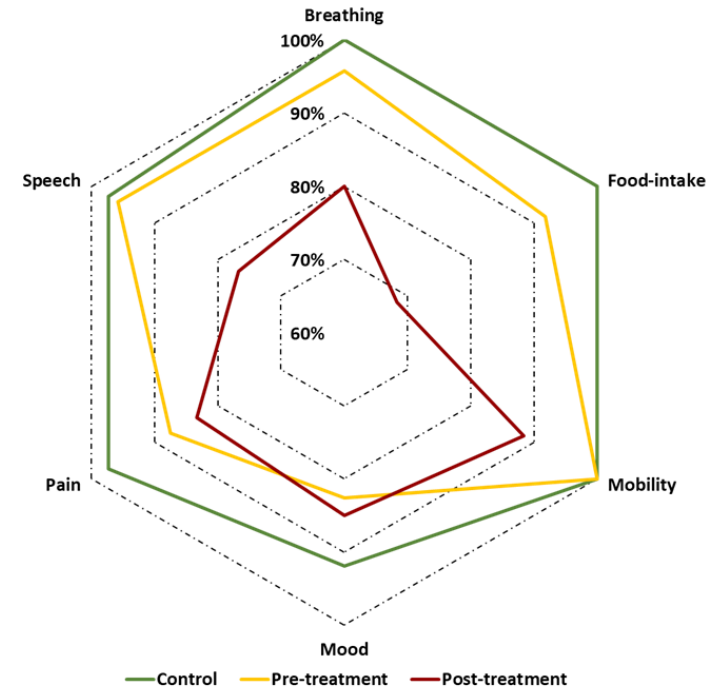
Figure 1. Star plot showing the percentages of normal and near-normal scores (functional integrity; scores 3 and 4) for controls (green line), HNC patients before therapy (yellow line), and HNC patients after therapy (red line). The star axes represent the percentages of study participants with functional integrity for the functional domains breathing, food intake, neck and shoulder mobility, mood, pain, and speech.